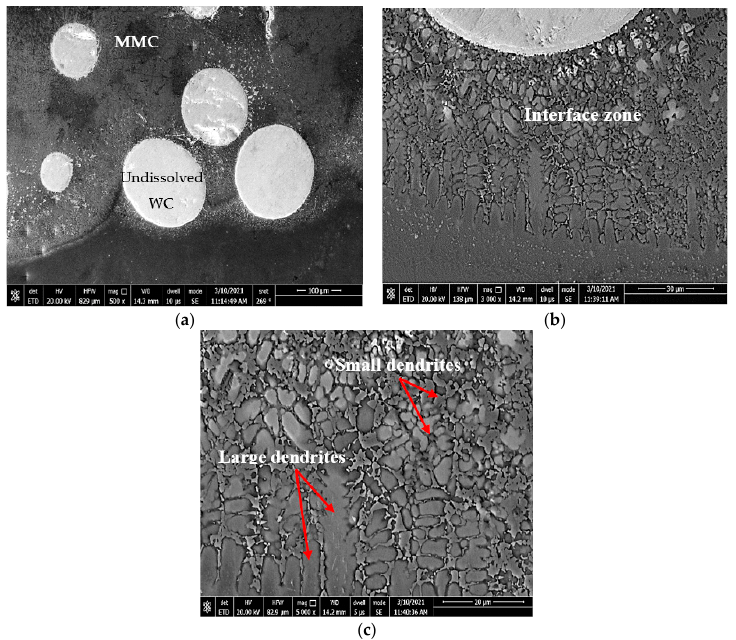
Figure 10. FESEM micrographs of the ( a ) hypoeutectic structure at the DZ, ( b ) dendritic structure at the IZ, and ( c ) large dendrite structure close to the fusion line.